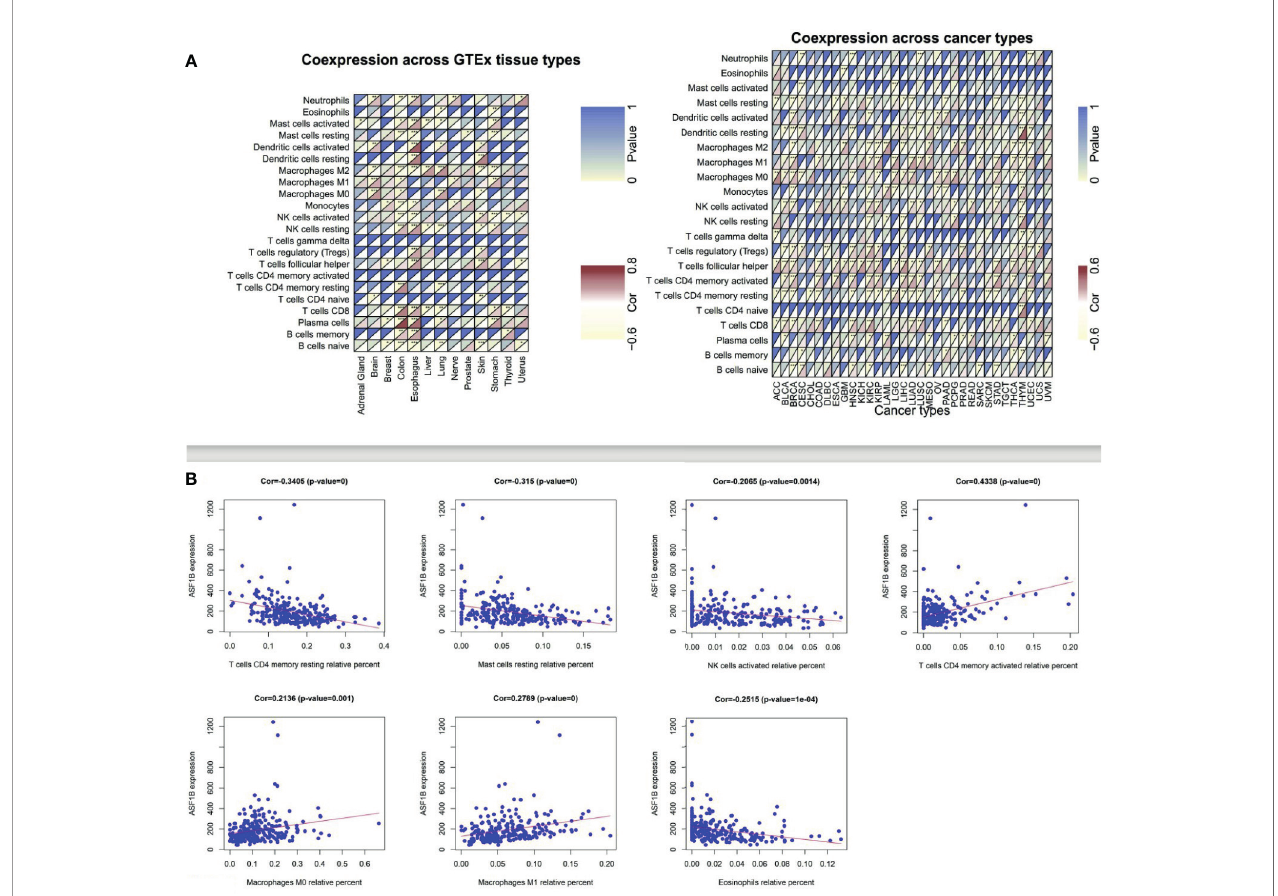
FIGURE 4 | Correlation analysis between ASF1B and tumor-in fi ltrating immune cell. (A) Correlation analysis of ASF1B mRNA expression with 22 types of immune cells were explored across cancers and normal tissues from TCGA and GTEx by CIBERSORT. (B) Correlation analysis of ASF1B mRNA expression with immune cells were further investigated in LUAD from GEO by CIBERSORT. *p value ≤ 0.05; **p ≤ 0.01; *** p value ≤